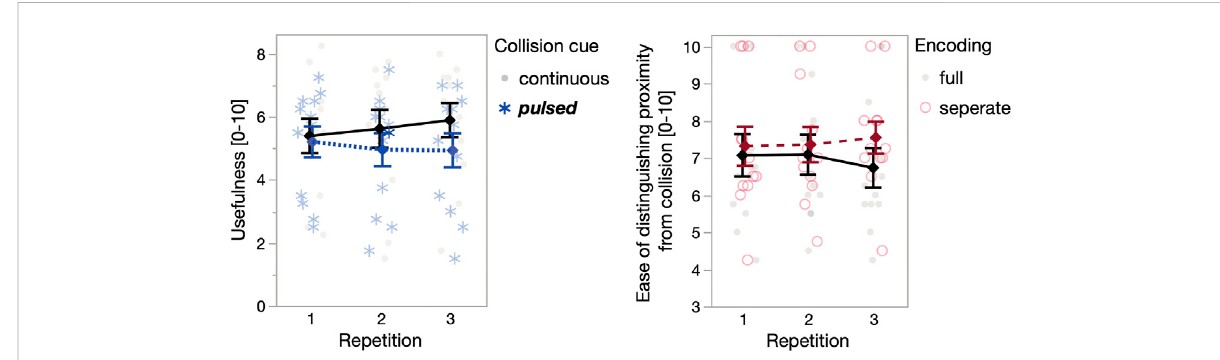
FIGURE 6 Illustration of signi fi cant interactions effects of repetitions in Study 3, plotted as in Figure 4.